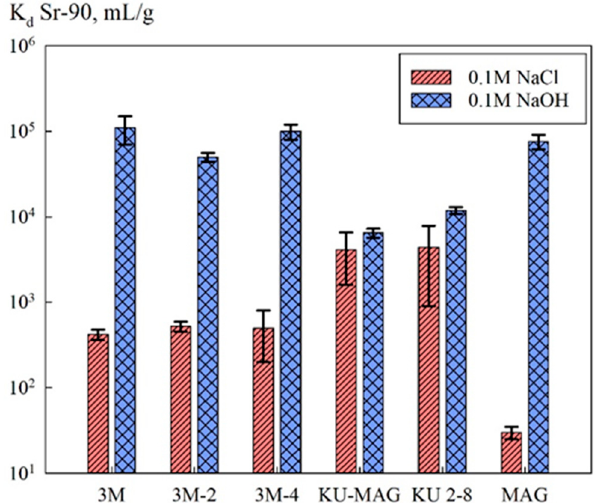
Figure 6. Sorption-selective characteristics of the sorbents.